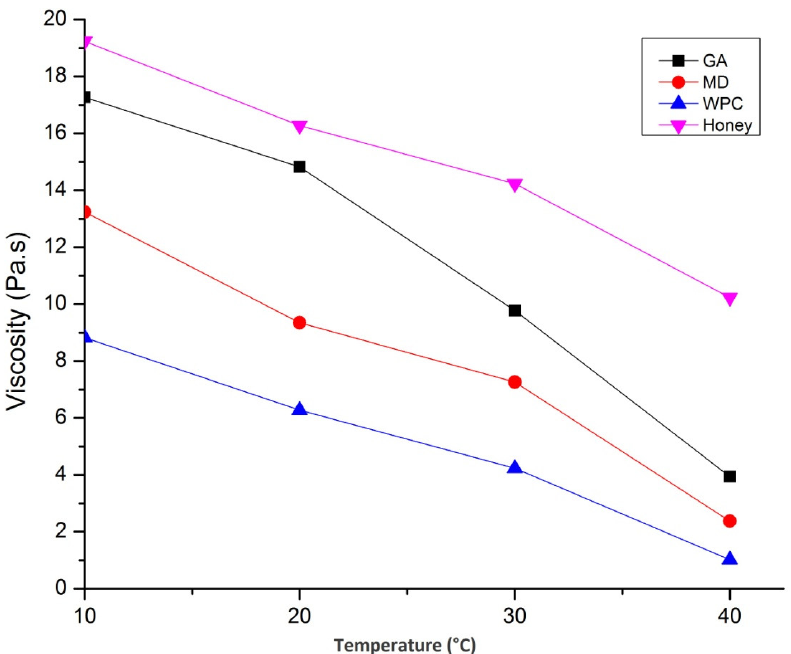
Figure 8. Effect of temperature on viscosity of honey and nutritionally rich honey powders fortified with maltodextrin (MD), gum arabic (GA), and whey protein concentrate